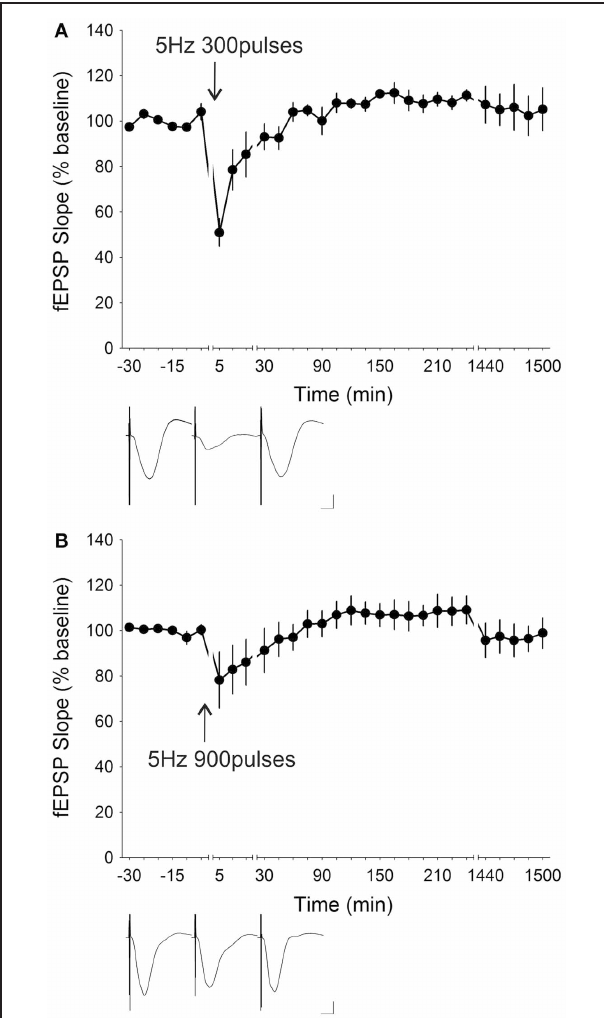
FIGURE 8 | Stimulation at 7Hz resulted in varying degrees of synaptic depression depending on the number of stimuli administered. (A) Low-frequency stimulation (LFS) at 7Hz elicited a small initial depression of 70 . 06 ± 5 . 05% that was significant for up to 10min post-stimulation when applied for 100 pulses (ANOVA, p = 0 . 27804; n = 7). (B) Increasing the number of stimuli to 300 pulses at 7Hz led to an enhancement of the initial depression (14 . 63 ± 3 . 81%) as well as the persistence of the depression (ANOVA, p = 0 . 55473; n = 8). Insets: analog traces illustrating the Schaffer collateral–CA1 field potentials at pre-stimulation, 5min and 24h (1440min). Vertical scale bar corresponds to 2mV and horizontal scale bar corresponds to